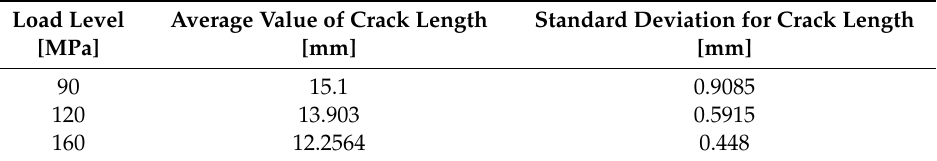
Table 4. Average and standard deviation values for crack